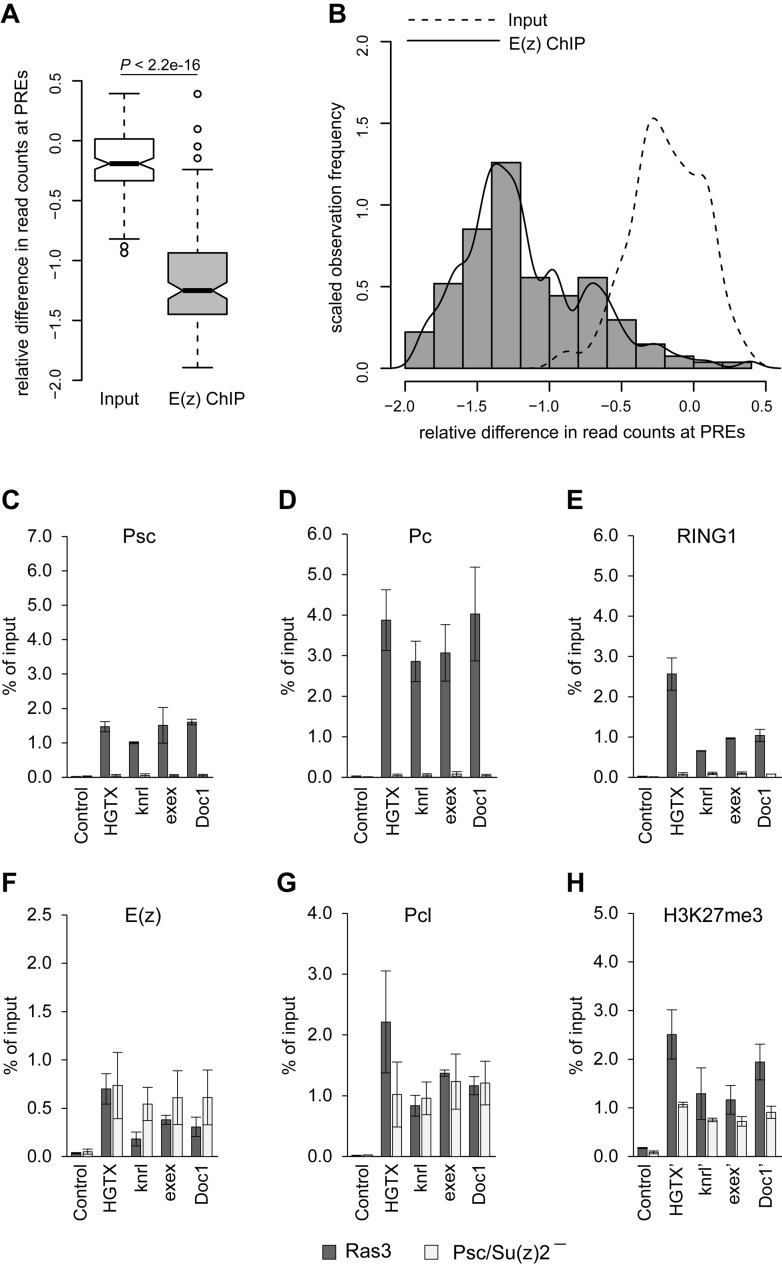
Overview of PRC2:PRC1 dependence at PREs. (A) The box-plots compare the relative difference in the average number of sequence read counts at PREs (n = 135) measured by E(z) ChIP-seq experiments with Psc/Su(z)2 minus and Ras3 control cells (grey boxplot, ‘E(z) ChIP’) to the relative difference of in the average number of read counts after sequencing corresponding chromatin input samples (white boxplot, ‘Input’). The boxplots indicate the median and span the inter-quartile range. The whiskers indicate the lowest and the highest values excluding outliers, which are defined as values outside of 1.5 time inter-quartile range. Notches correspond to the 95% confidence intervals of the median values. At most PREs the loss of ChIP-seq signal in Psc/Su(z)2 minus cells is greater than variability between Input sequencing experiments and the overall difference is statistically significant (Wilcoxon rank sum test). (B) The histogram and the solid density fitting curve illustrates the distribution of relative differences in the number of E(z) ChIP-seq read counts (RD) at different PREs between Psc/Su(z)2 minus and Ras3 control cells. The long right tail of the distribution overlaps with the distribution of relative differences of the read counts in the control Input sequencing experiments (dashed curve). All PREs with RD < −1.0 show clear PRC2:PRC1 dependence. The PREs with RD > −0.5 are likely to be PRC2:PRC1-independent. The observation frequencies (y-axis) are scaled such that the total area underneath the histograms equals one. (C–H) ChIP-qPCR analyses of PcG proteins and H3K27me3 at a set of PRC2:PRC1 independent PREs in control (Ras3) and Psc/Su(z)2 minus cells.